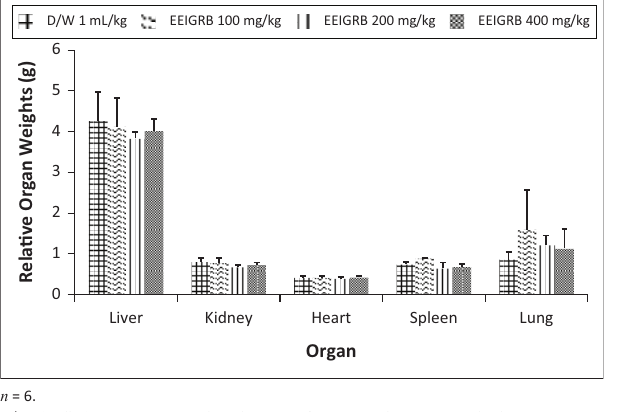
FIGURE 2: Effect of 28 days of oral administration of ethanol extract of Irvingia gabonensis root bark on relative organ–body weights of rats. Values are presented as mean ± standard error of mean; there were no significant differences when compared with the control group (distilled water).